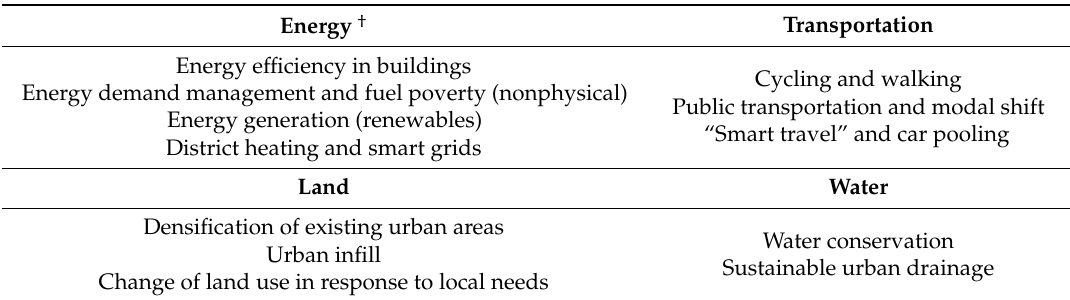
Table 1. Types of regeneration policies, plans, and actions from an environmental